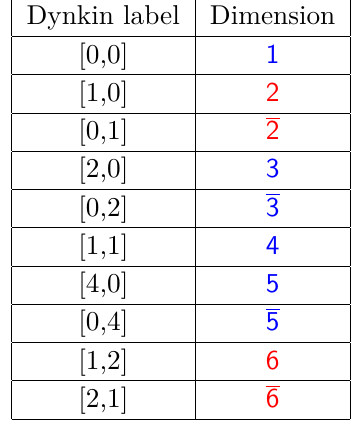
Table 9 . so (4) irreducible representations